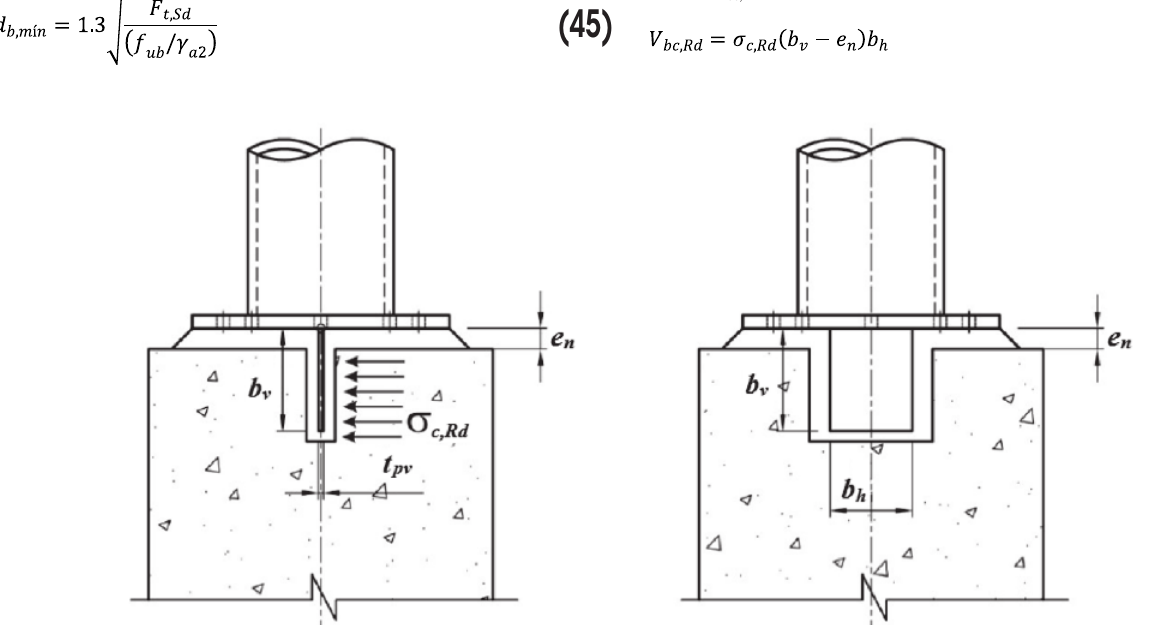
Base de pilar de aço com barra de